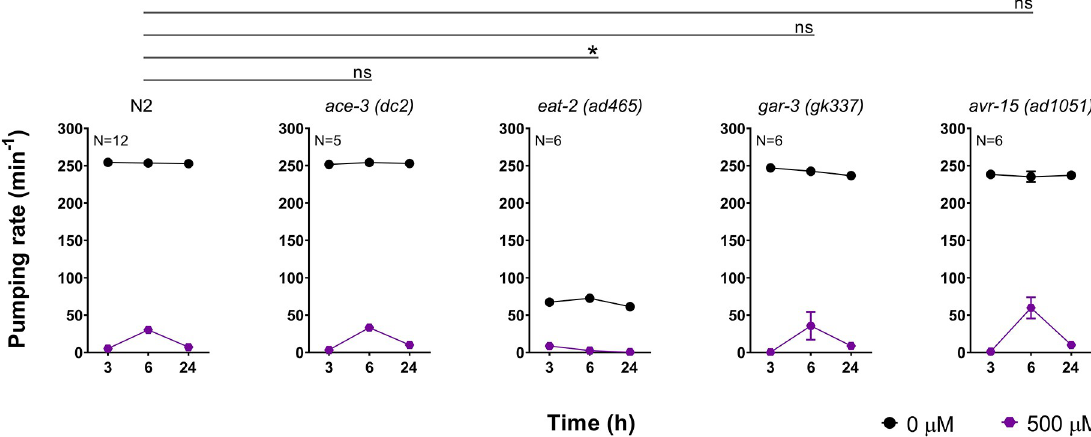
Fig 5. The paraoxon-ethyl induced changes in pharyngeal pumping are not elicited by components underpinning pharyngeal neuromuscular function. N2 wild type nematodes continuously exposed to 500 μ M paraoxon-ethyl exhibited in drug recovery of the pharyngeal function at 6 hours followed by a subsequent inhibition at 24 hours. Data are shown as mean ± SEM of 16 worms in at least 8 independent experiments (N = 16). The acetylcholinesterase ACE-3 of C . elegans is specifically expressed in the isthmus of the pharynx [41]. ACE-3 deficient nematodes exposed to 500 μ M paraoxon-ethyl exhibit a similar in-drug recovery followed by inhibition of the pharyngeal pumping rate compared to wild-type worms. Data are shown as mean ± SEM of 5 worms in at least 3 independent experiments (N = 5). Nematodes lacking EAT-2 did not exhibit the in drug recovery observed in wild type worms. Data are shown as mean ± SEM of 6 worms in at least 3 independent experiments (N = 6). The muscarinic receptor GAR-3 is expressed in the isthmus and is involved in the feeding movement [46]. Mutant nematodes lacking GAR-3 exhibited a similar paraoxon-induced plasticity of the pumping rate compared to the wild type worms. Data are shown as mean ± SEM of 6 worms in at least 3 independent experiments (N = 6). E) avr-15 encodes a glutamate-gated chloride channel subunit responsible for the relaxation of the pharyngeal muscle upon contraction [45]. avr-15 mutant worms exhibit a similar pattern of pharyngeal pumping rate than wild type animals intoxicated on 500 μ M paraoxon-ethyl plates. Data are shown as mean ± SEM of 6 worms in at least 3 independent experiments (N = 6). Statistical significance was calculated by two-way ANOVA test followed by Bonferroni corrections. ns p > 0.05; * p � 0.05.